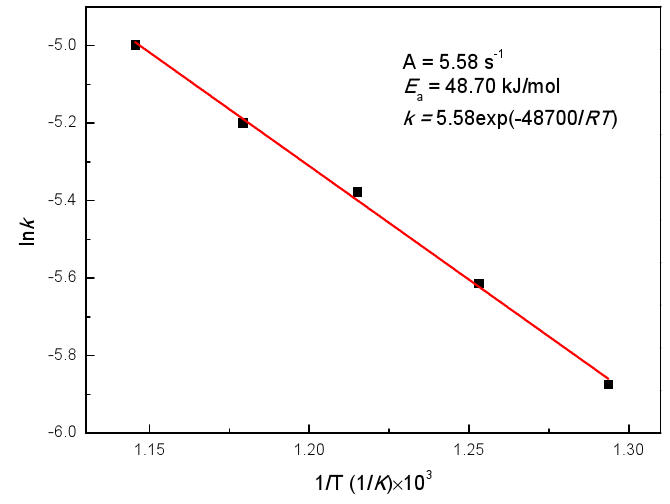
Figure 9. Arrhenius plot ln k = f (1/ T ) for the evaluation of the activation energy of the process.